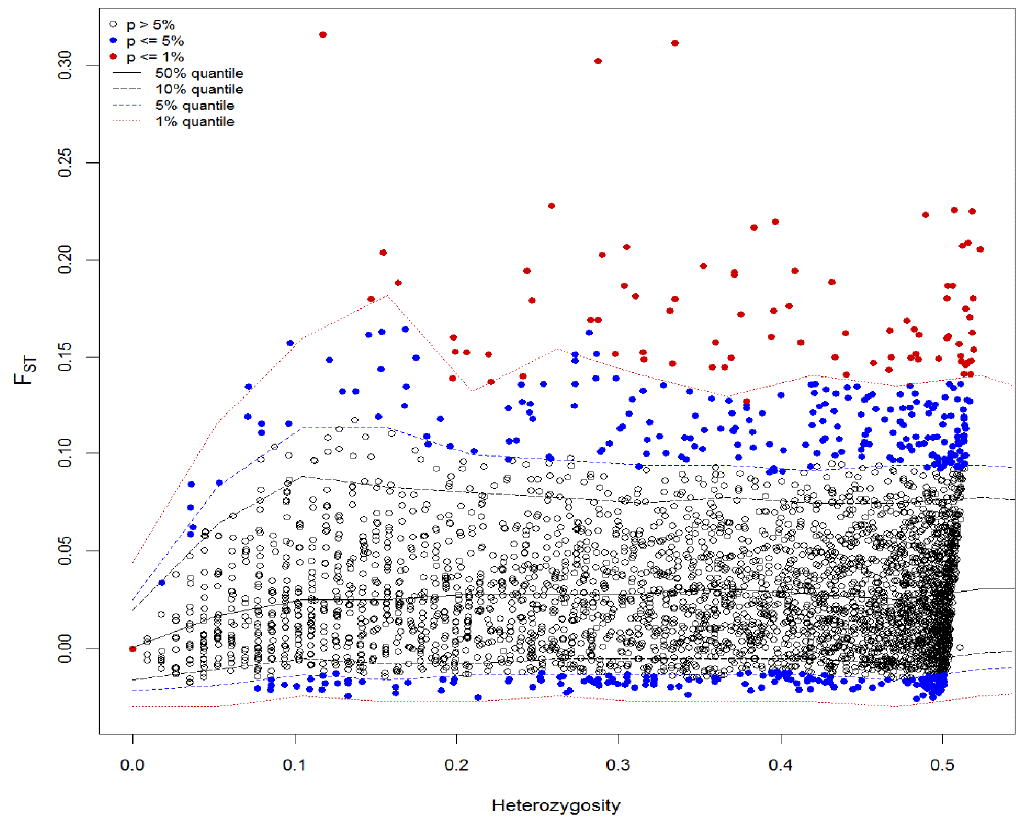
Figure 4. Analysis of outlier SNPs using a hierarchical model: SNPs that are above the 99% quantile of the simulation model were considered as SNPs under potential selection. SNPs above the upper solid line were considered as candidates for divergent selection, and those below the lower solid line were considered as candidates for balancing selection. SNPs that are between the dashed blue lines are neutral. Genes 2020 , 11 , x FOR PEER REVIEW